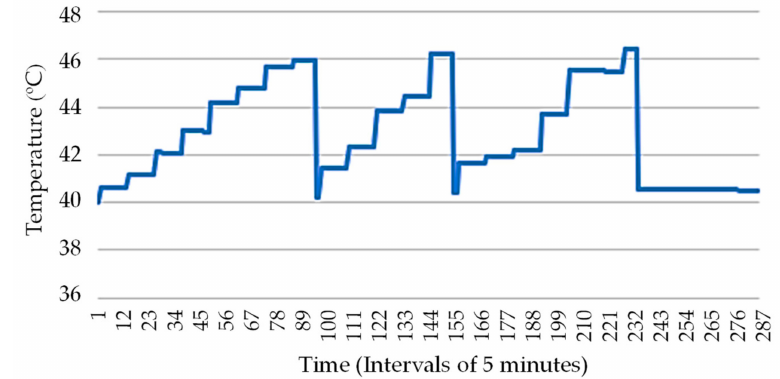
Figure 6. Evolution of the temperature in the sanitarian water heater, during the day, considering the real time pricing scheme.